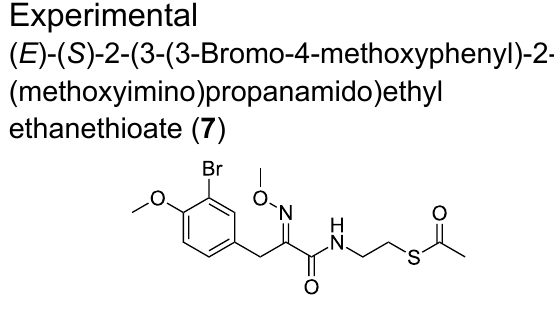
bilities to prepare HDAC inhibitors bearing diverse thioester zinc-binding groups. Variation of the thioester functionality to protect its lability in cells and potentially orient suitable func- tionality into the internal cavity of HDACs [32] remain exciting avenues for future